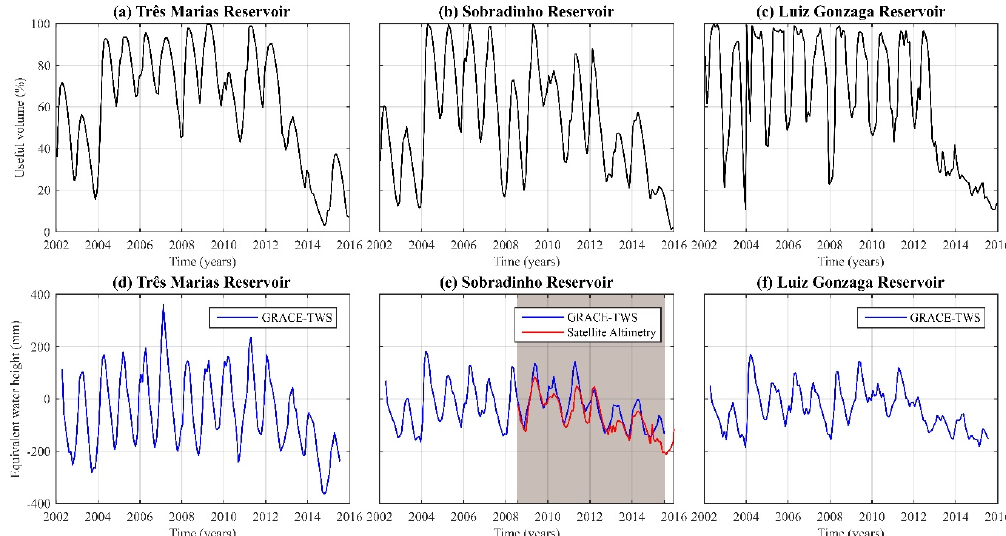
Figure 4. The top panels: ( a – c ), show the useful volume in percentage (%) of the main reservoirs within SFRB (see Figure 1 for locations), namely, Três Marias Reservoir, Sobradinho Reservoir, and Luiz Gonzaga Reservoir; the bottom panels: ( d – f ), show the TWS series (blue solid lines), expressed as equivalent water layer in mm, over a quadrangle area of 3° × 3° centered at approximately the mid-point of each reservoir; additionally, panel ( e ) shows the water mass variations (red solid line) of the Sobradinho Reservoir observed from satellite altimetry and averaged over the correspondent quadrangle area where the gray rectangle shows the overlap period ( i.e. , from July 2008 to July 2015). The Sobradinho Reservoir (Figure 4b), the largest reservoir of the SFRB and the Northeast Brazil, went through one of the worst droughts within the time span of January 2002 to December